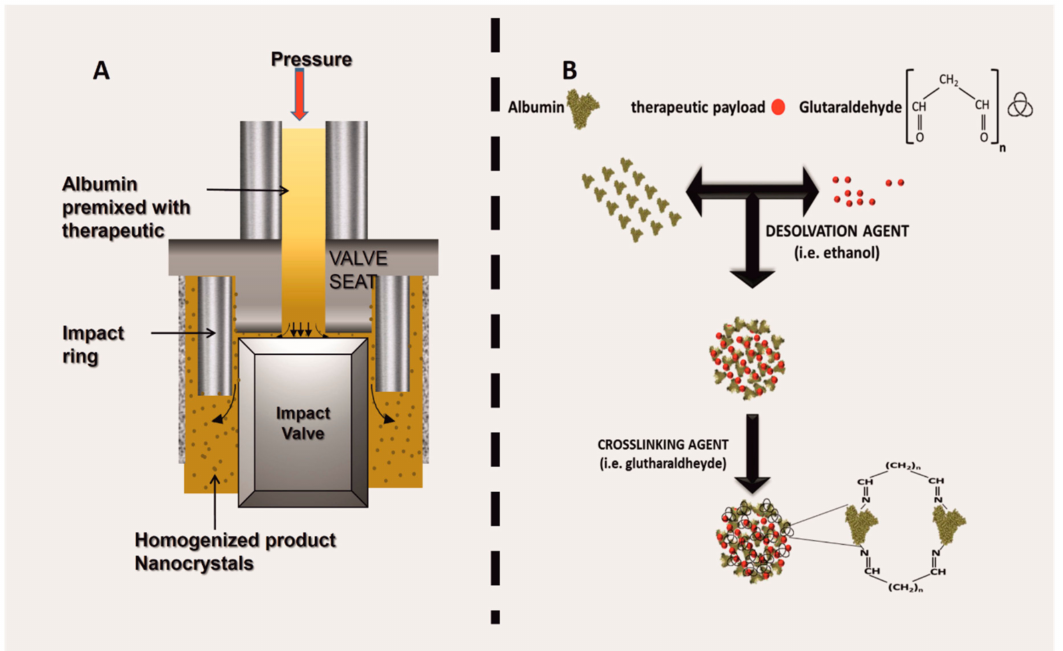
Figure 2. Albumin nanovector (ANV) synthetic routes, namely: ( A ) schematic of the working mechanism of a high-pressure homogenization; ( B ) synthesis through desolvation, followed by